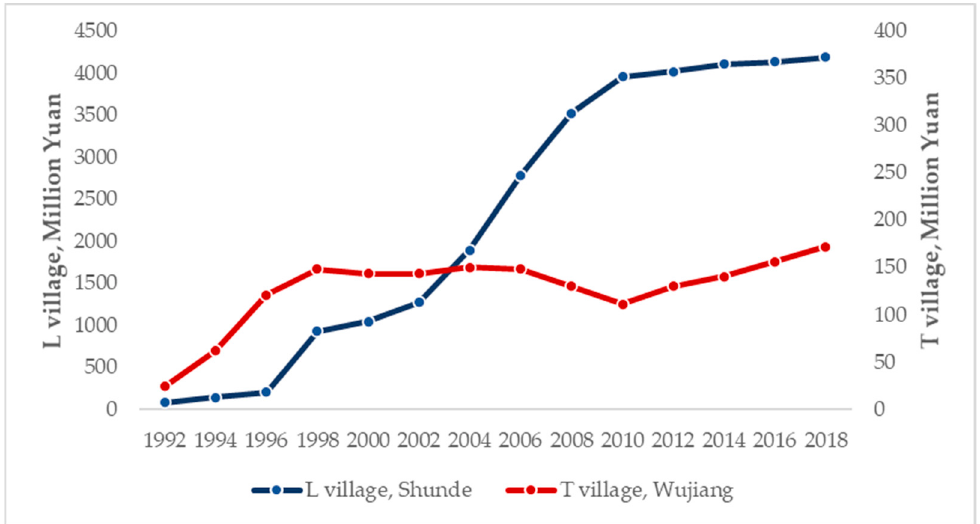
Figure 6. Collective-owned assets changes of L village in Shunde and T village in Wujiang in 1992–2018.